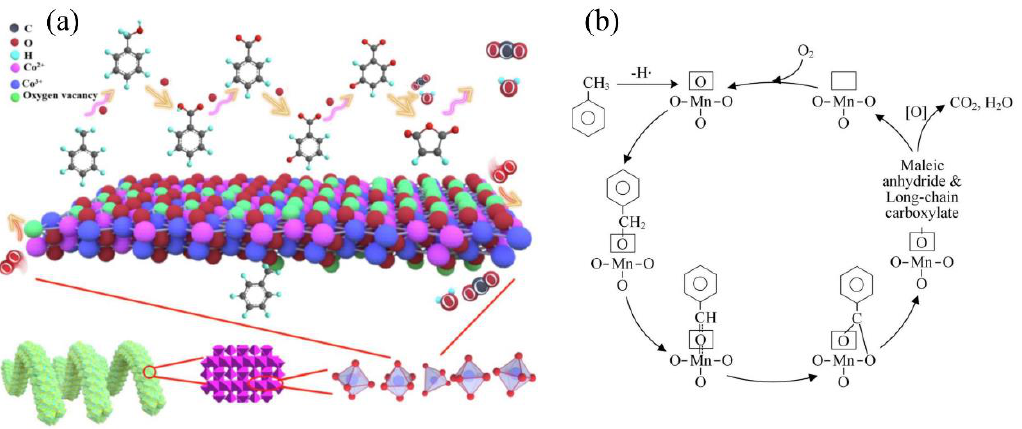
Figure 3. The possible reaction mechanism and pathway over the NH/Tri-Co3O4 ( a ) catalysts [36] and MnO2-Ac ( b ) catalysts [27]. Copyright 2022 and 2020, Elsevier B.V. and MnO2-Ac ( b ) catalysts [27]. Copyright 2022 and 2020, Elsevier